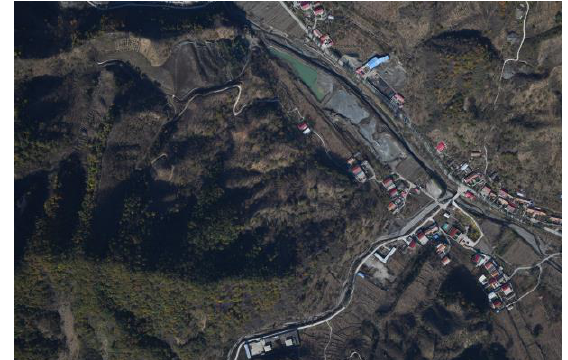
Figure 5. One of the UAV